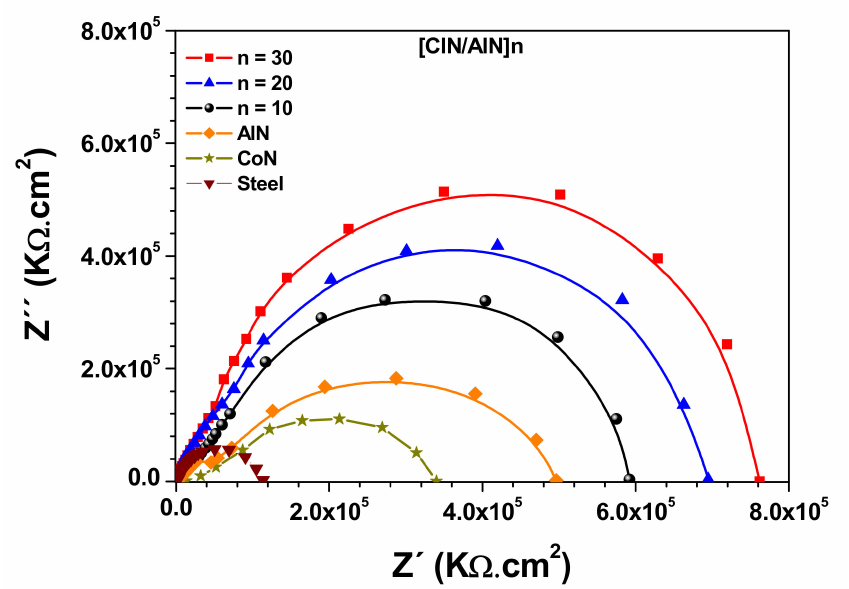
Figure 10. Electrochemical impedance diagrams for AISI 302 steel coated with AlN and CoN single layers and multilayer systems [AlN/CoN]n.